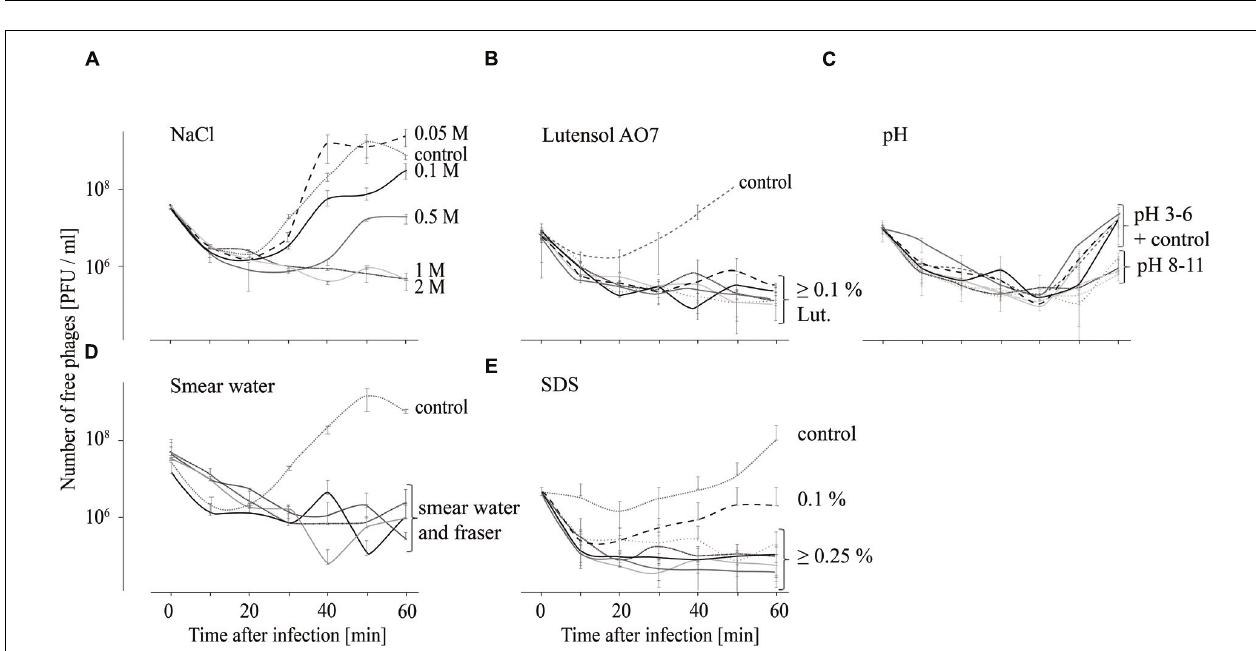
FIGURE 1 | Infectivity of P100 stored in smear water and SM buffer at 4 ◦ C (A) and 10 ◦ C (B) for 117 days. Smear water was either untreated (as obtained from the dairy plant), autoclaved or centrifuged in order to remove bacterial or eukaryotic (e.g., yeast) cells. Further, L. monocytogenes EGDe was added to one smear water sample. Experiments were done twice in duplicates and mean values and standard deviations were shown.